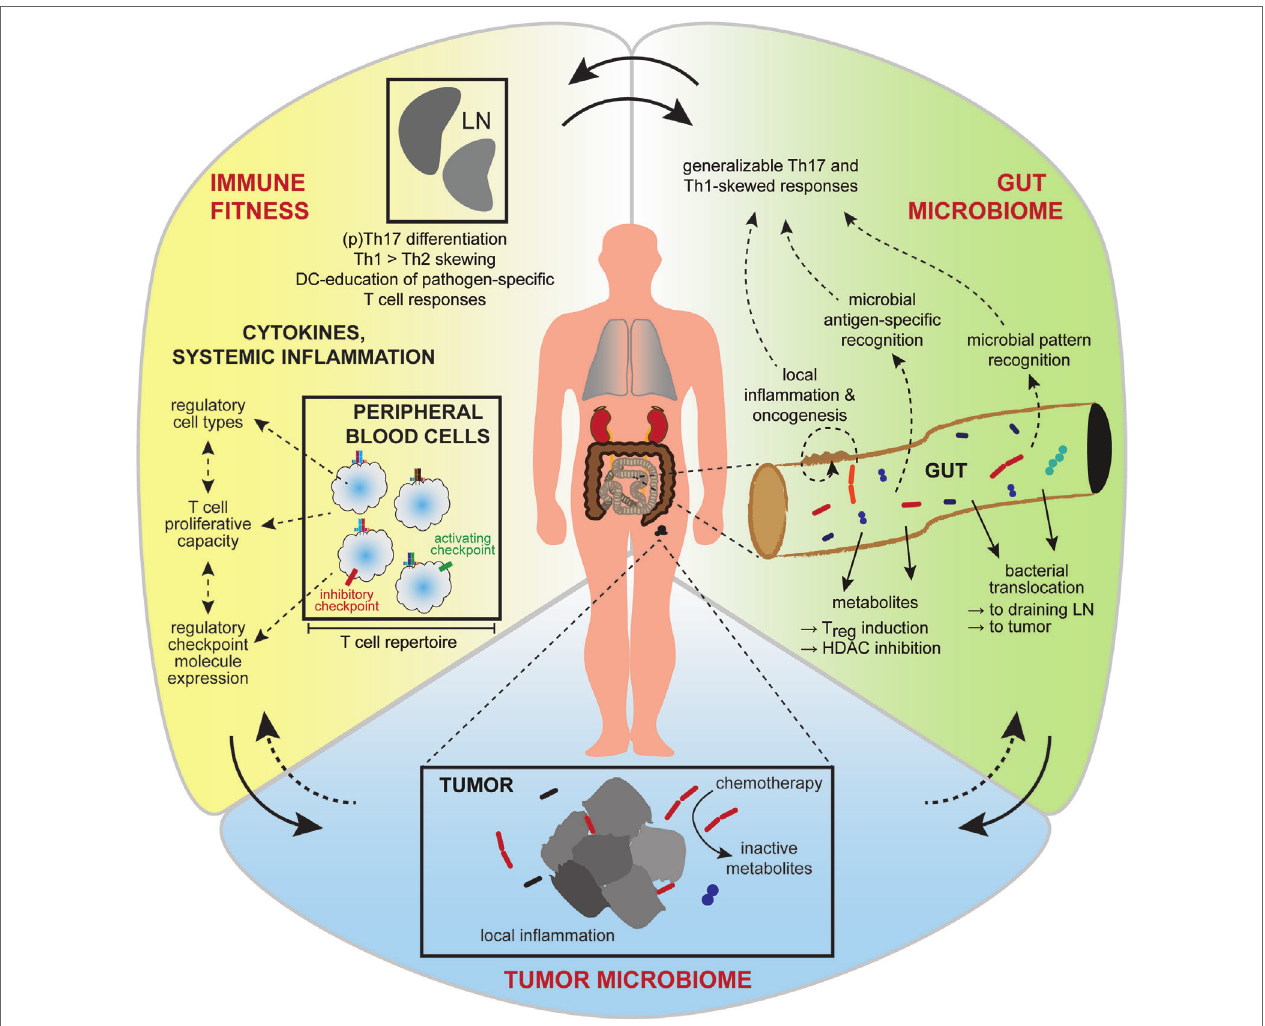
FiGURe 2 | Interactions between the gut and intra-tumoral microbiota and the systemic immunity affect treatment outcome. Broader influences on tumor growth and responsiveness to immunotherapy are now realized, including contributions from the gut microbiome, the tumor microbiome, and systemic factors affecting general immune fitness. Interactions between these conceptual compartments are complex and incompletely understood. Gut microbiota ( green ) have diverse metabolic and antigen or pattern-molecule immunogenic effects on local gut inflammation, the effects of which contribute to local carcinogenesis or can become generalized to affect cancer growth and immunity at distant body sites. Favorable immune fitness ( yellow ), characterized by overall skewing toward cellular immune responses, a permissive cytokine milieu and activation-biased representation of anti-tumor, and regulatory immune cell types, is important for anti-tumor responses. The intra-tumoral microbiome ( blue ) is of emerging significance, having local inflammatory and metabolic effects that influence therapeutic